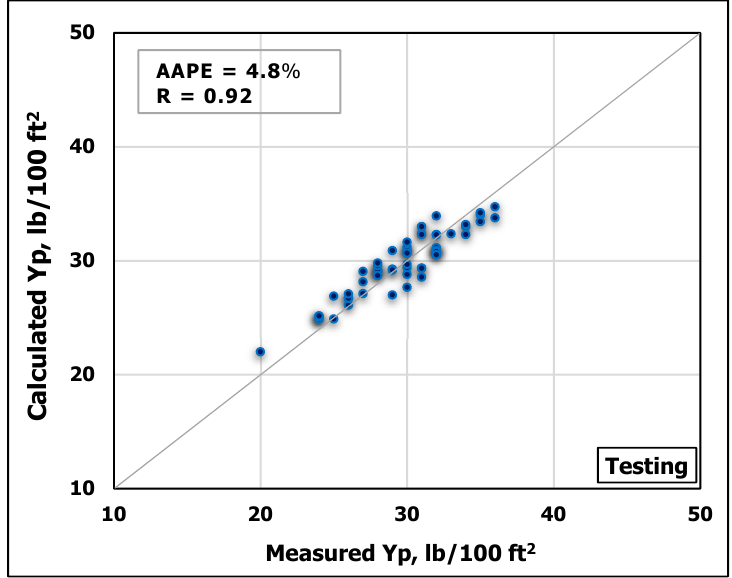
Figure 6. Measured Y P vs. predicted Y P from the ANN model for the testing process.